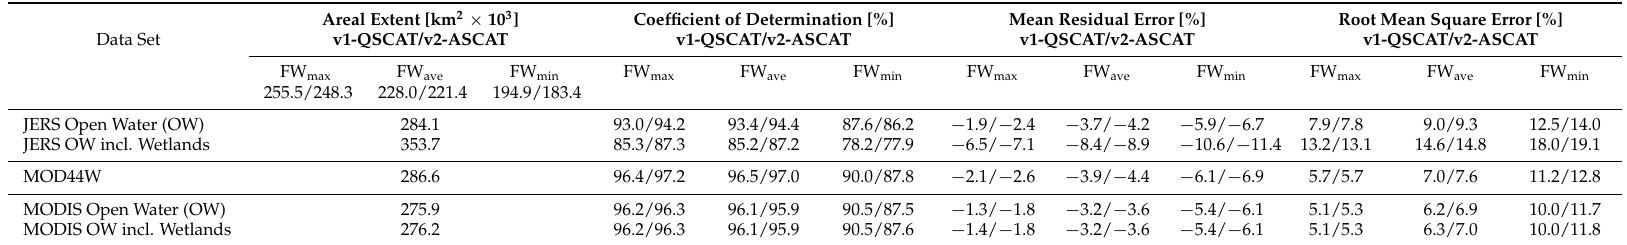
Table 6. Areal extent and summary statistics from pixel-wise comparisons of fractional water (FW) generated from v1-QSCAT (2000–2008) and v2-ASCAT (2009–2012) average annual maximum (FW max ), mean (FW ave ), and minimum (FW min ) record periods against maps of open water (OW) and wetlands derived from the L-band Japanese Earth Resources Satellite (JERS)-based Alaska wetland map and static FW from the MOD44W and MODIS including wetlands products over the state of Alaska (54 ˝ N–72 ˝ N, 143 ˝ W–170 ˝ W). Relationships are significant at a minimum 0.01 probability level.